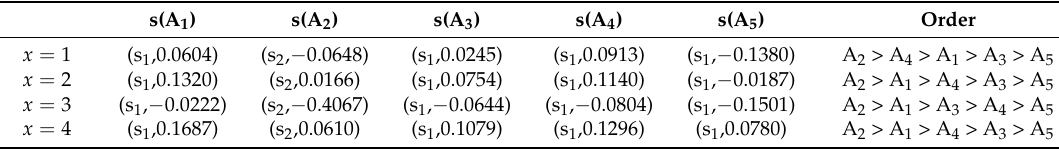
Table 9. Order for different parameters of 2TLPFDWHM